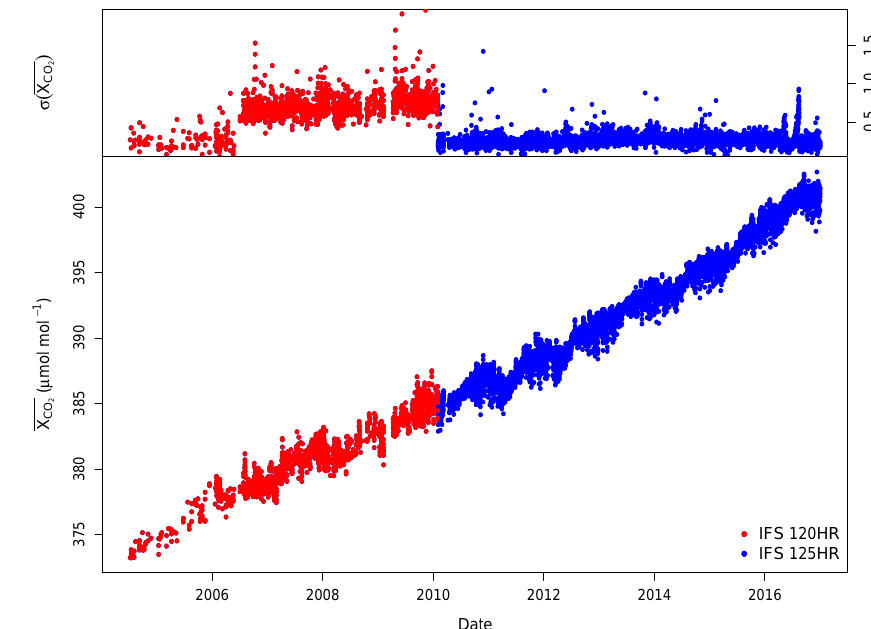
retrieved from measurements made with both FTS instruments at Lauder. 2